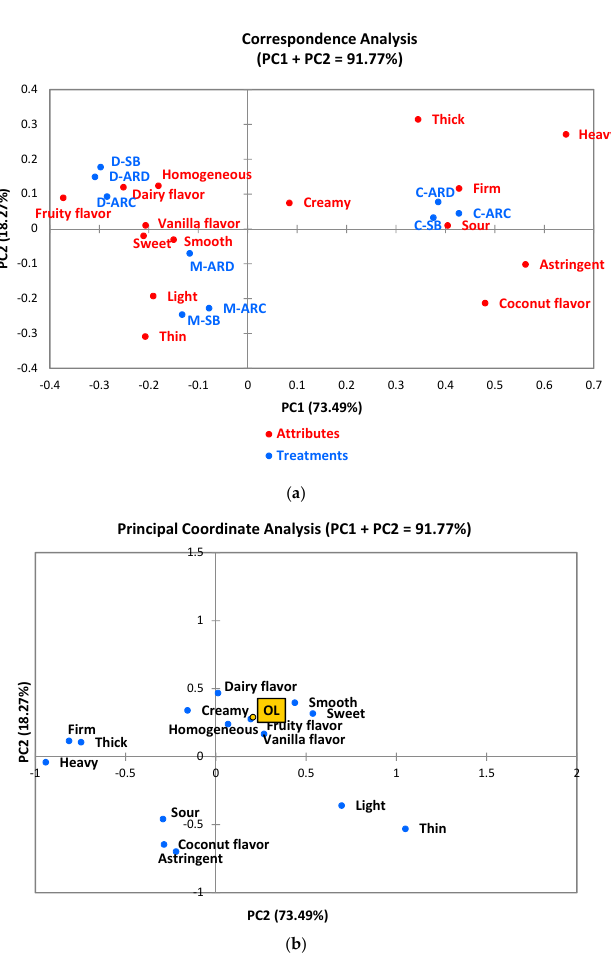
Figure 3. ( a ) Correspondence analysis of the CATA attribute terms for the yogurts under the different environments and ( b ) principal coordinate analysis of the CATA descriptive terms with the overall liking score (OL). The description of the treatment’s labels can be found in the footnote of Table 2.